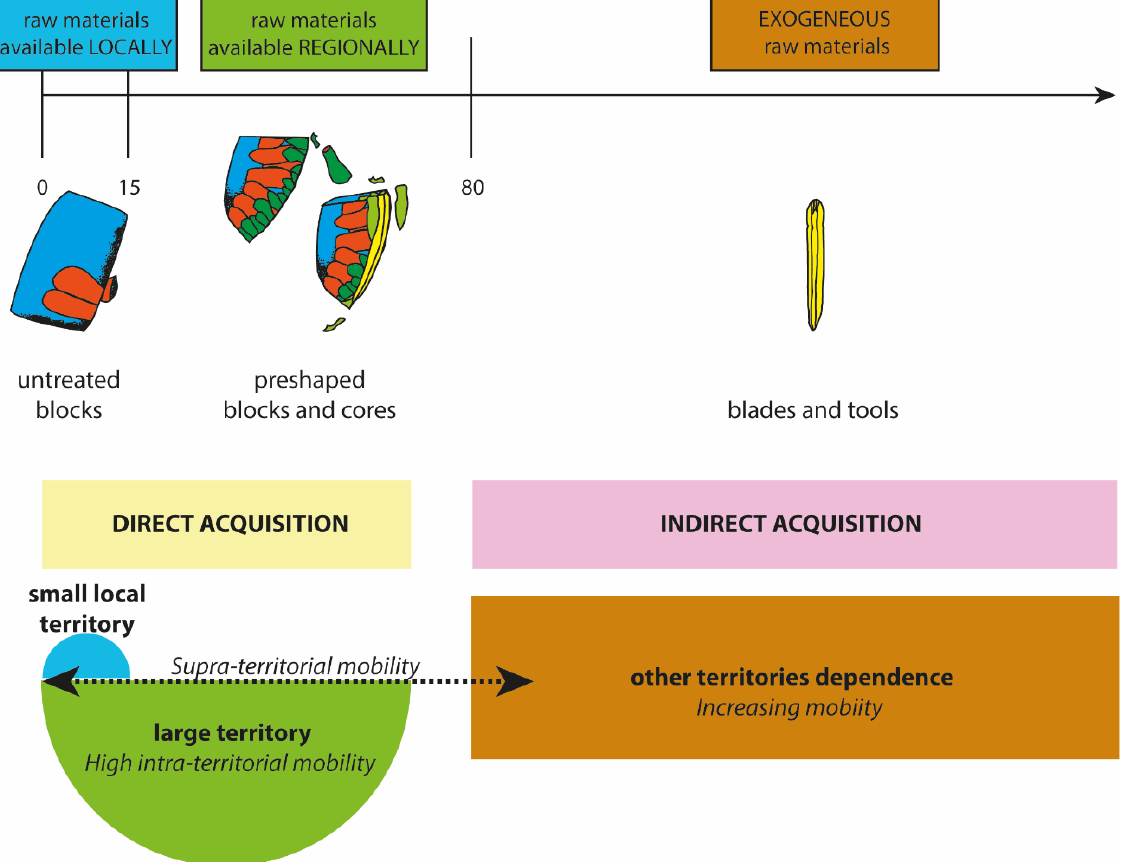
Figure 8. Schematic territories for flint procurement in the Paris